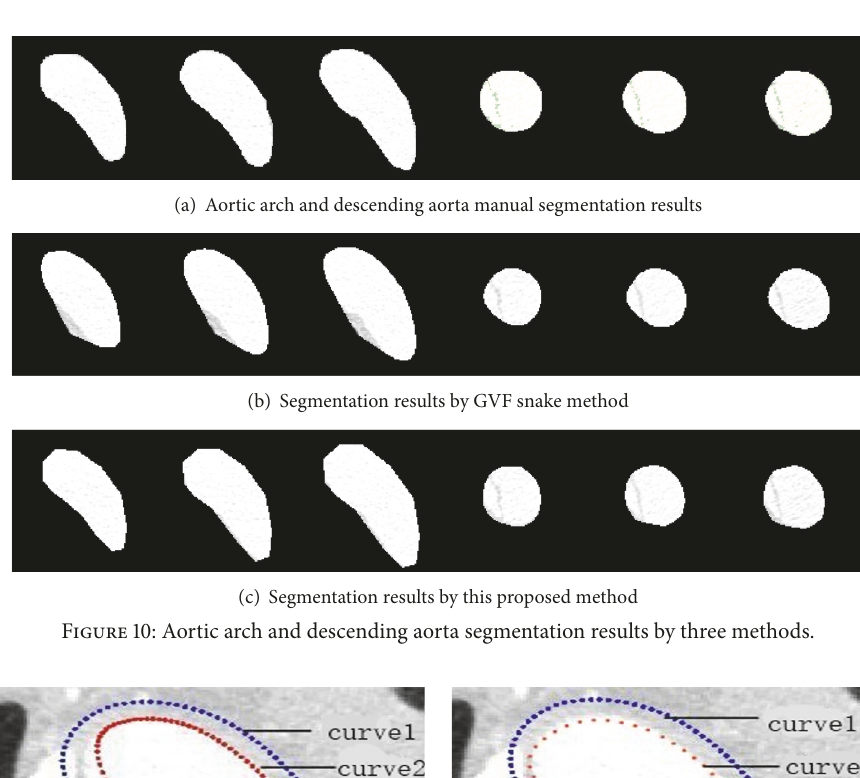
Figure 9: 3D visualization model of another two patients with aortic dissection.